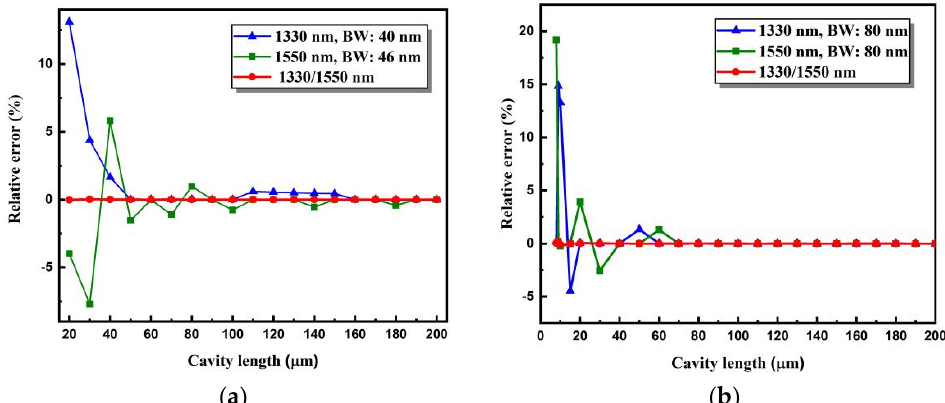
Figure 7. Simulated demodulation deviations of fiber-optic F–P sensors with different cavity lengths under different illuminating conditions of a single 1330 or 1550 nm SLD or two SLDs simultane- ously. ( a ) The single 1330 or 1550 nm SLD has a spectral width of 40 and 46 nm, respectively. ( b ) The single 1330 or 1550 nm SLD has a spectral width of 80 nm. In both cases, for the dual-SLD demodulation, the 1330 nm SLD is with a 40 nm spectral width, and the 1550 nm SLD is with a 46 nm spectral width.